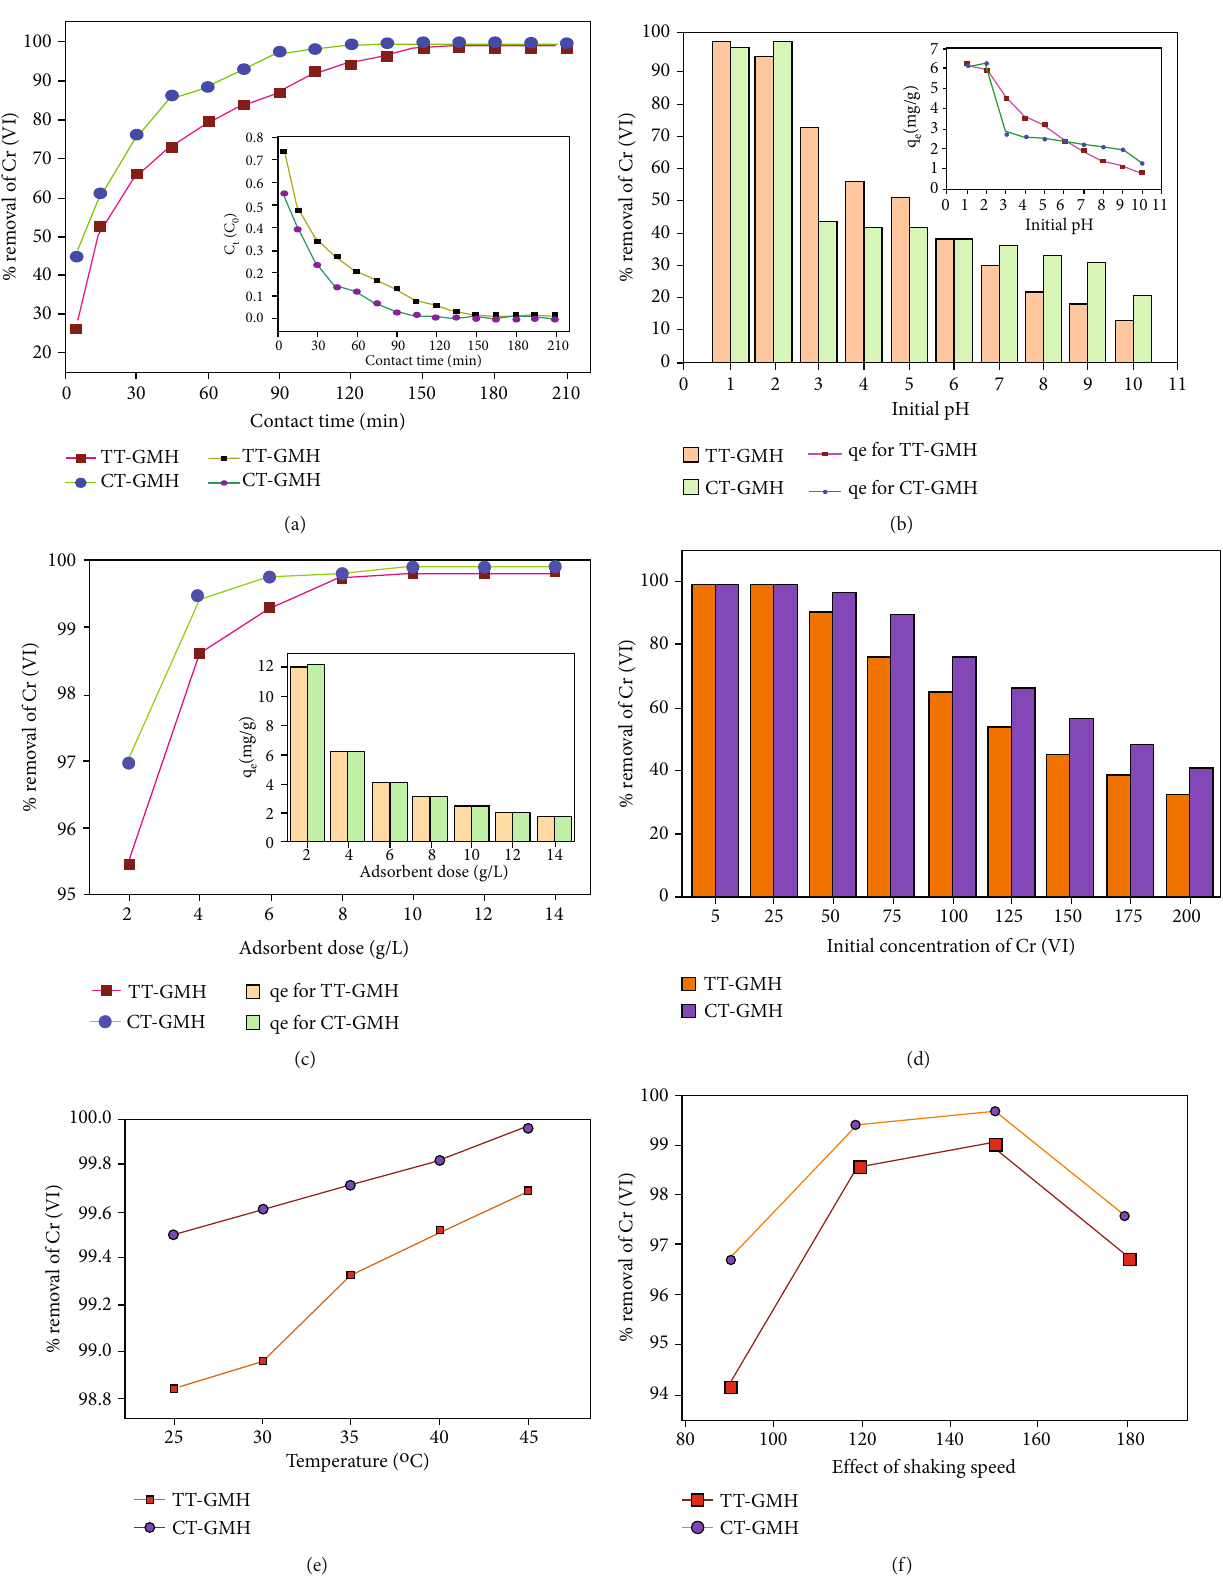
Figure 5: E ff ect of (a) contact time, (b) initial pH, (c) adsorbent dose, (d) concentration of Cr(VI), (e) temperature, and (f) RPM of batch adsorption